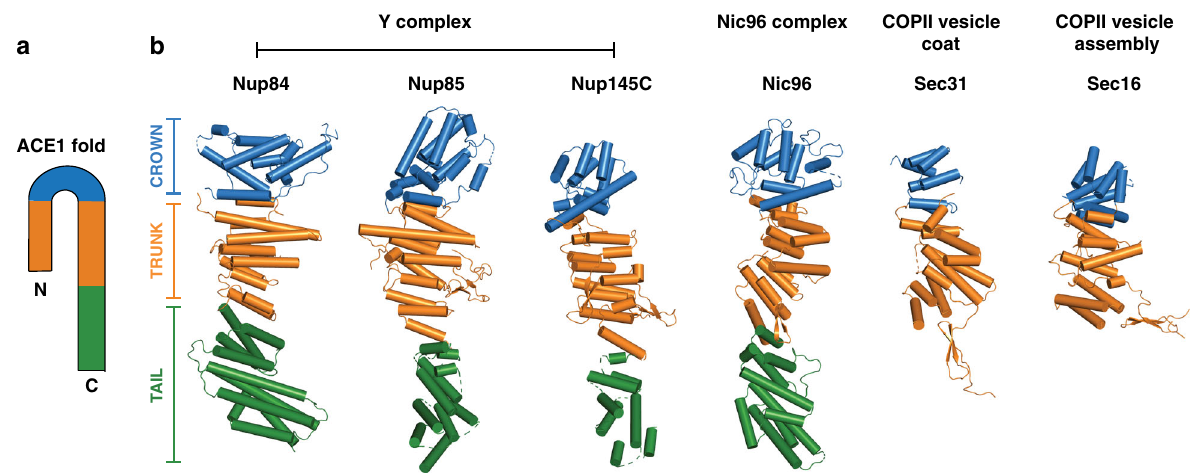
Fig. 2 ACE1 domain proteins of the Nuclear Pore and COPII vesicle coat. a ACE1 fold topology schematic. b ACE1 fold proteins. Domains indicated by color: Crown (blue), trunk, (orange), tail (green). PDB codes are as follows: Nup84 (this study), Nup85 (4XMM), Nup145C (4XMM), Nic96 (2QX5), Sec31 (2PM6), Sec16